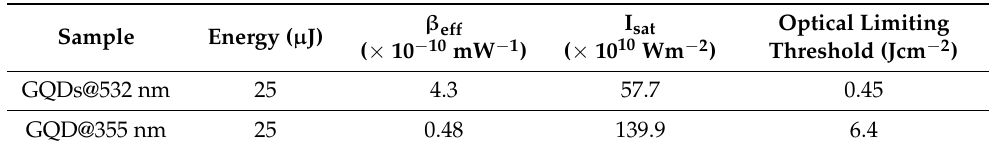
Table 1. Nonlinear absorption coefficient ( β eff ) and saturation intensity (I Sat ) for ns excitations, obtained by numerical fits to the data